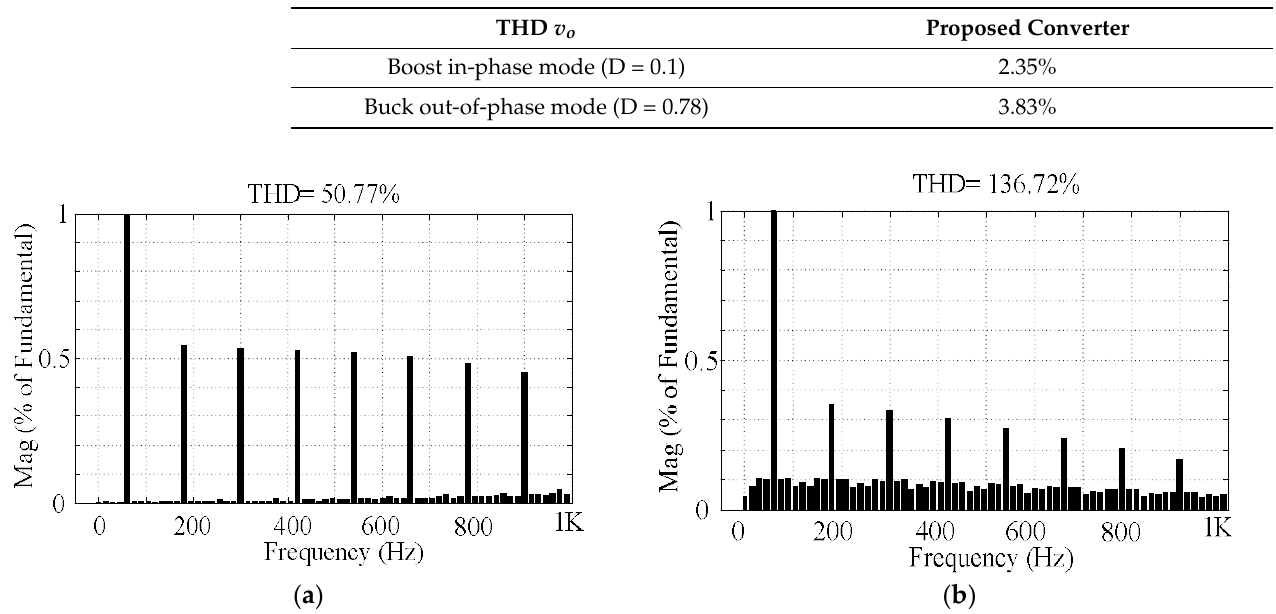
Table 4. THD v o in the proposed converter.